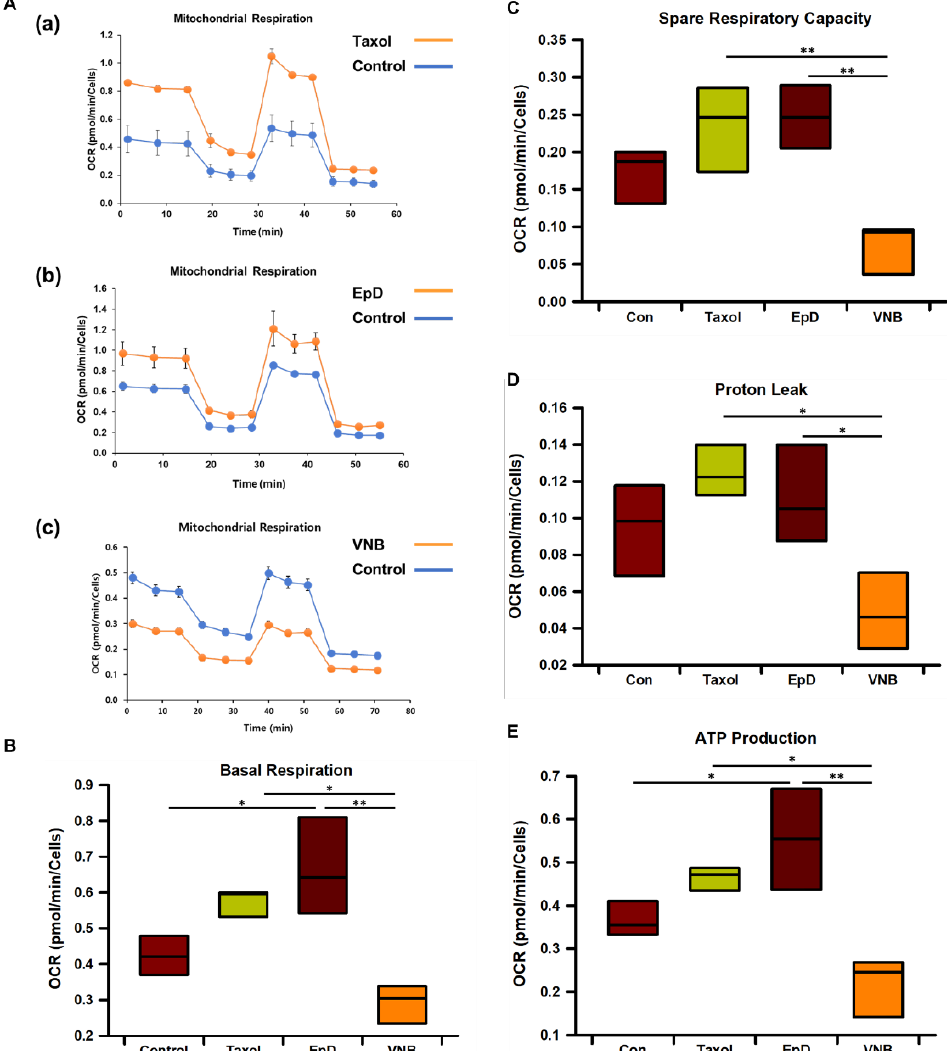
Figure 2. Analysis of mitochondrial respiration in microtubule stabilizer- and microtubule disturber-treated cells. ( A ) Real-time mitochondrial respiration, indicated by the OCR, in ( a ) Taxol-treated, ( b ) EpD-treated cells, and ( c ) VNB-treated cells (orange line), as well as control cells (blue line), measured using an extracellular flux analyzer. ( B ) Basal respiration, ( C ) the spare respiratory capacity, ( D ) proton leak, and ( E ) ATP production based on the OCR in cells treated with Taxol, EpD, and VNB measured using an extracellular flux analyzer. Data were automatically generated by the manufacturer’s software and are presented as means ± SEM ( n = 6 for control, Taxol-treated, EpD-treated, and VNB-treated cells). Statistical significance was determined by a one-way ANOVA. * p < 0.05, ** p < 0.01.